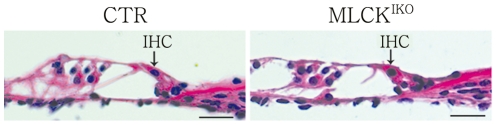
Hematoxylin & eosin (H&E)-stained sections of the organ of Corti in CTR and MLCKIKO mice.Arrows indicate inner hair cells. The structure of the organ of Corti appears normal in 4-month-old MLCKIKO mice (n = 5). Scale bars: 50 µm.